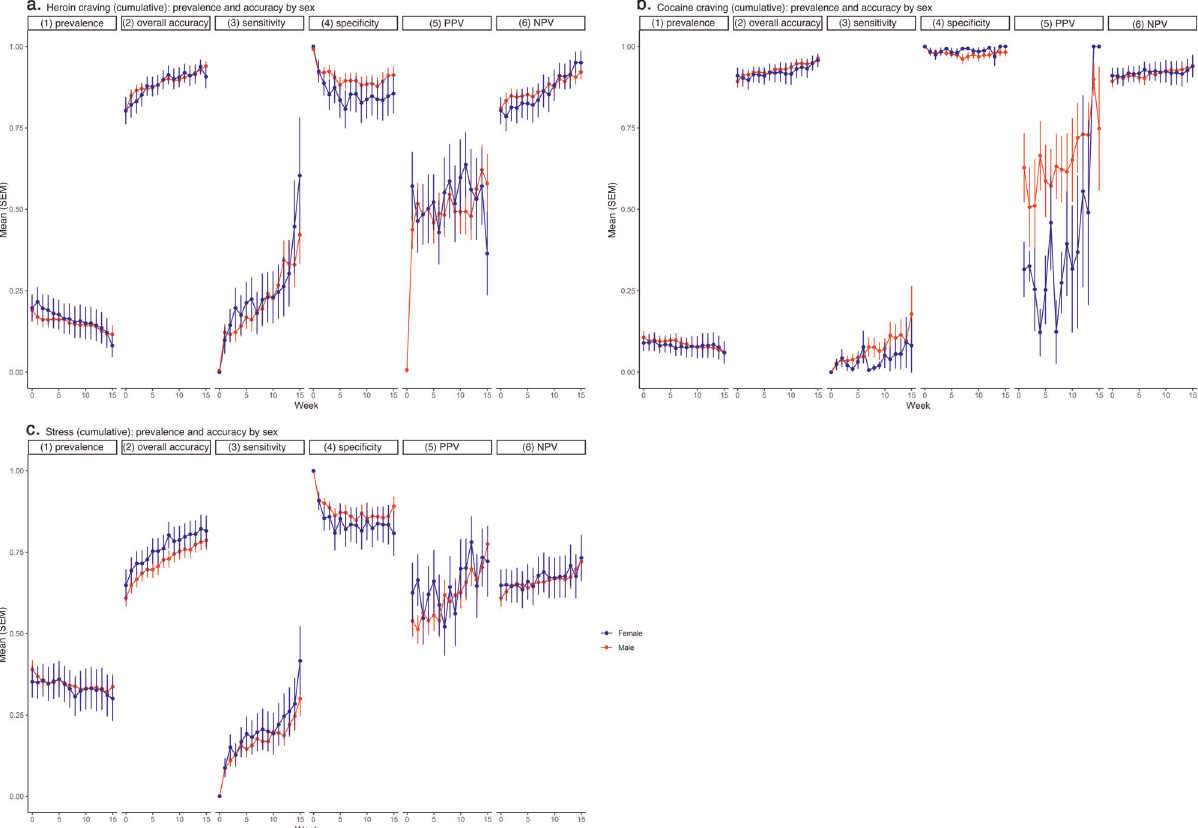
Fig. 4 Prediction accuracy (and prediction-target prevalence) per person per week, by sex. a Heroin craving, b cocaine craving, and c stress. There were 141 men and 48 women. Details as in Fig. 2.